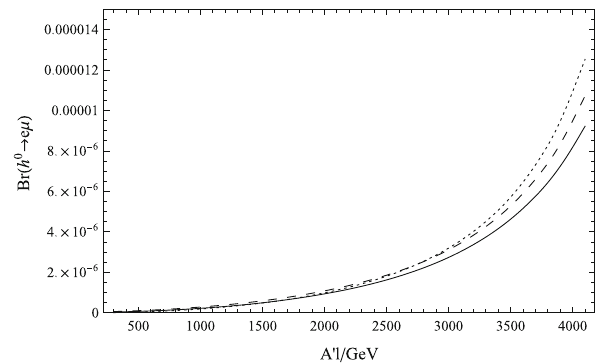
Fig. 18 The branching ratios of h 0 → μτ and h 0 → e τ versus param- eter A ˜ are plotted by the solid line and dashed line respectively E